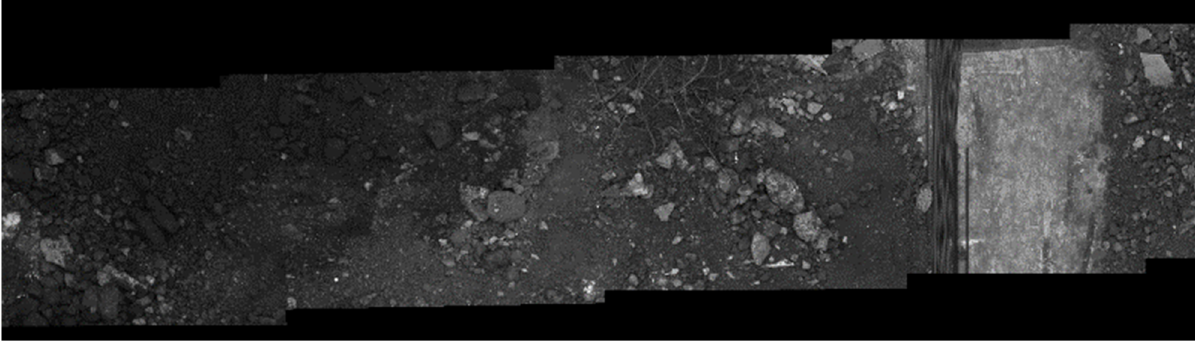
Figure 30. Push-broom ground test cover diagram.